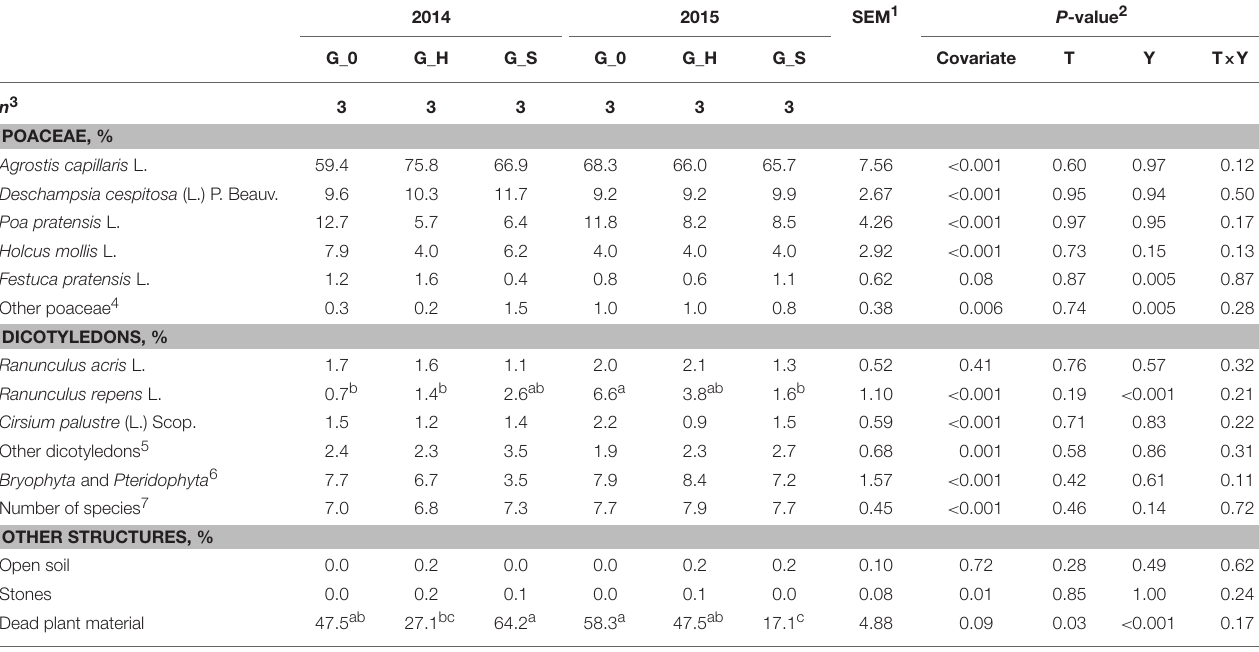
TABLE 2 | Effect of grazing treatment [(control without grazing (G_0), grazing with heifers (G_H) or grazing with sheep (G_S)] and year on vegetation ground cover estimated in autumn (Period 4) of 2014 and 2015 in permanent 1 × 1m squares.